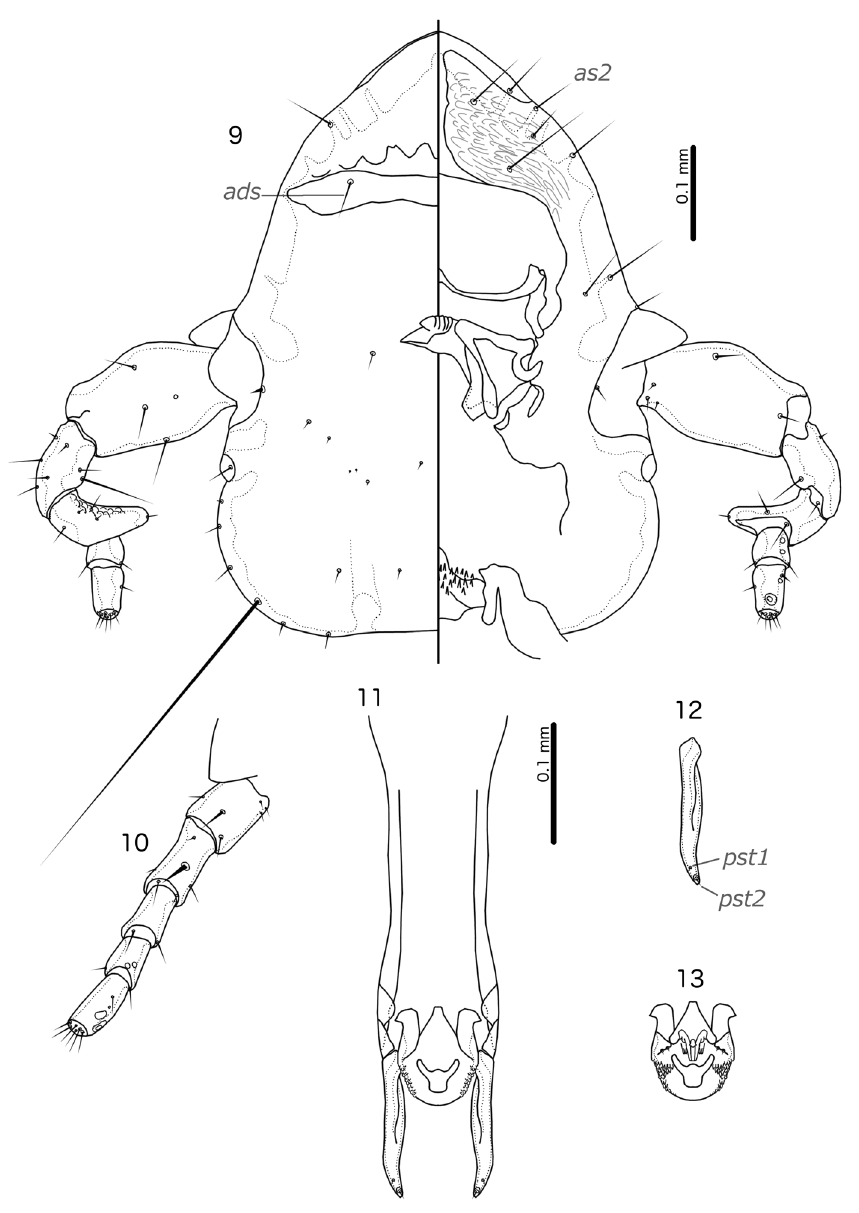
Figs 9–13. Gallancyra dentata (Sugimoto, 1934) gen. et comb. nov. ex Gallus gallus (Linnaeus, 1758) (NHMUK010682393) . 9 . Male head, dorsal and ventral views. 10 . Female antenna, ventral view. 11 . Male genitalia, dorsal view. 12 . Male paramere, dorsal view. 13 . Male mesosome, ventral